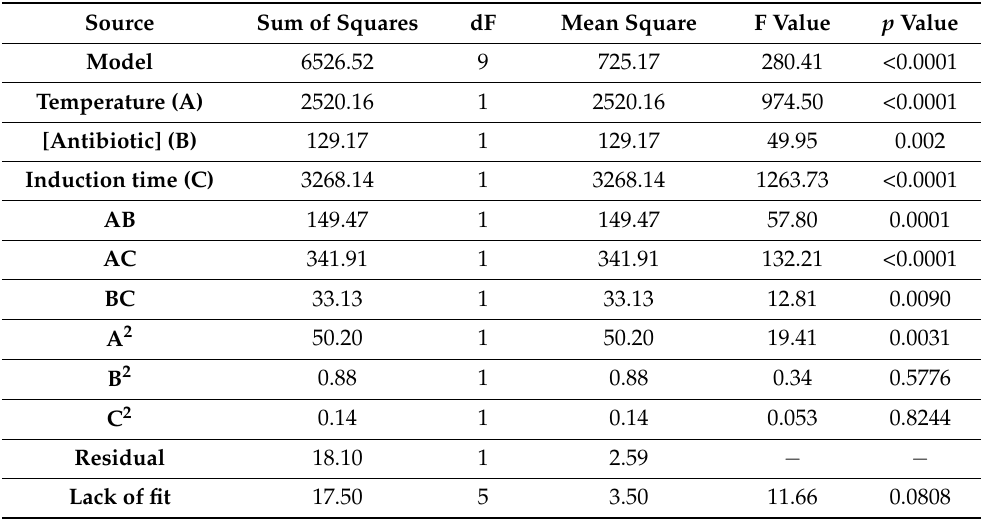
Table 3. ANOVA analysis for response surface quadratic model for the % of recombined mcDNA. p -value < 0.05 is considered